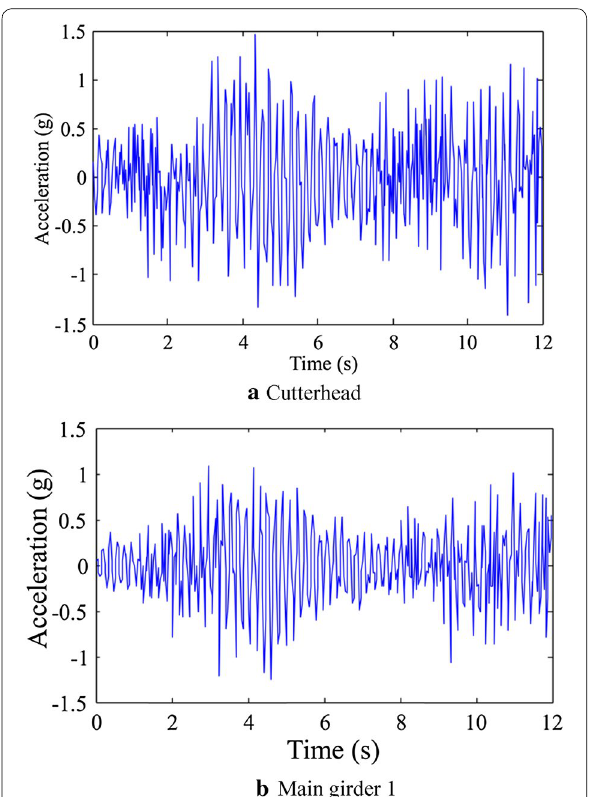
Figure 11 Vibration acceleration in the lateral